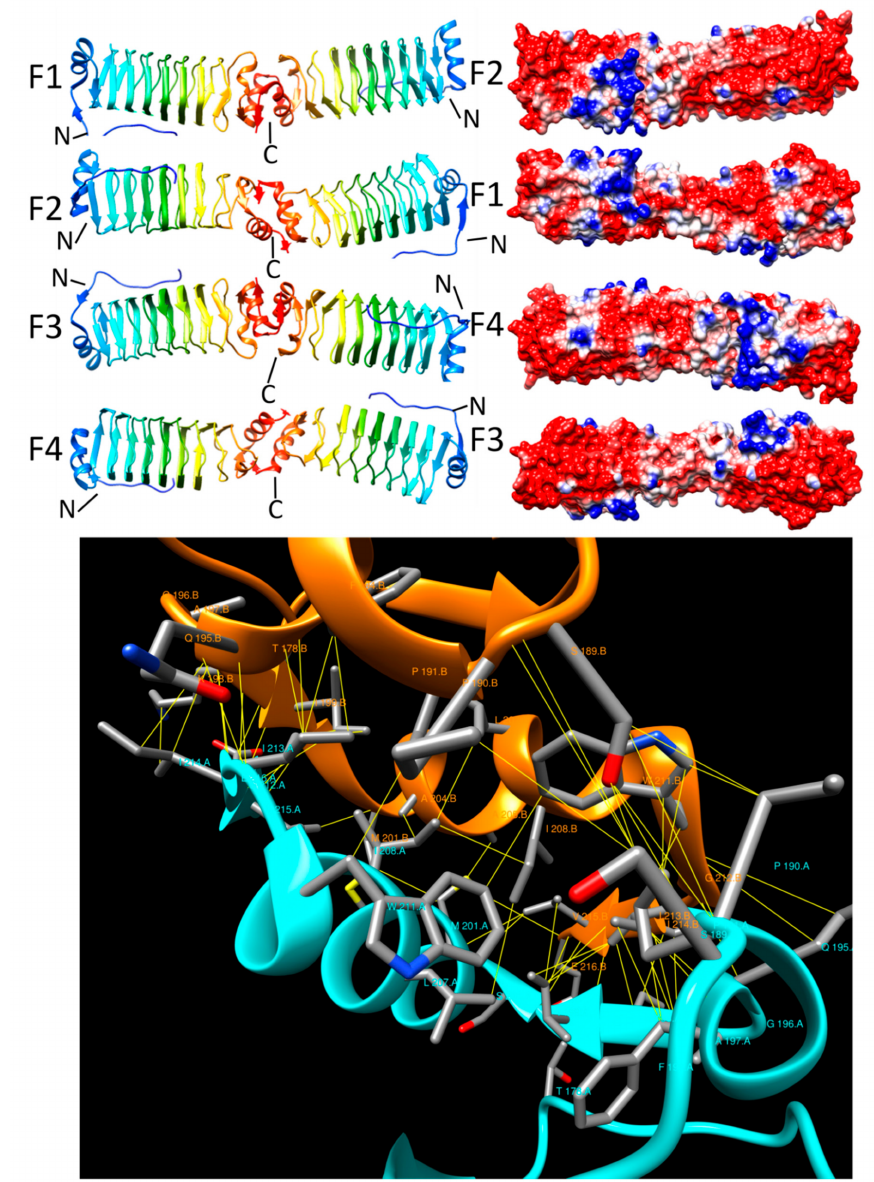
Figure 9. Structure and analysis of PENT. The top panel shows the ribbon diagrams of the structure for four different orientations (at left) and the corresponding electronic potential surface plots (at right). The bottom panel is the interface model calculated by Intersurf and depicted using